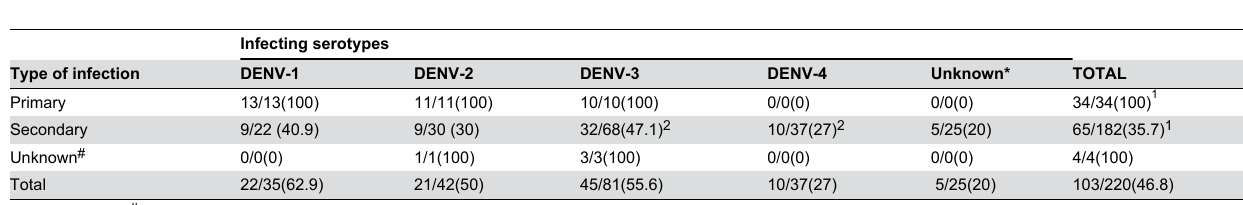
Table 2. Sensitivity of the NS1 antigen test according to infection status.